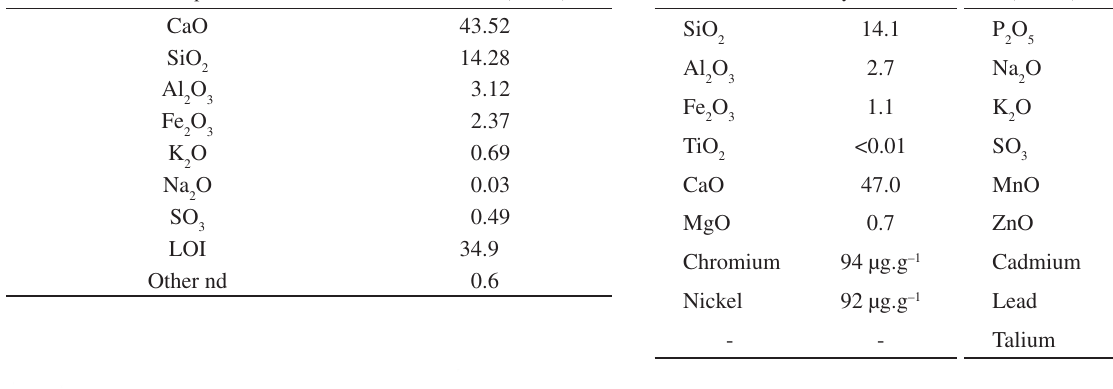
Table 1. Chemical composition of the raw material, as oxides (%w/w).